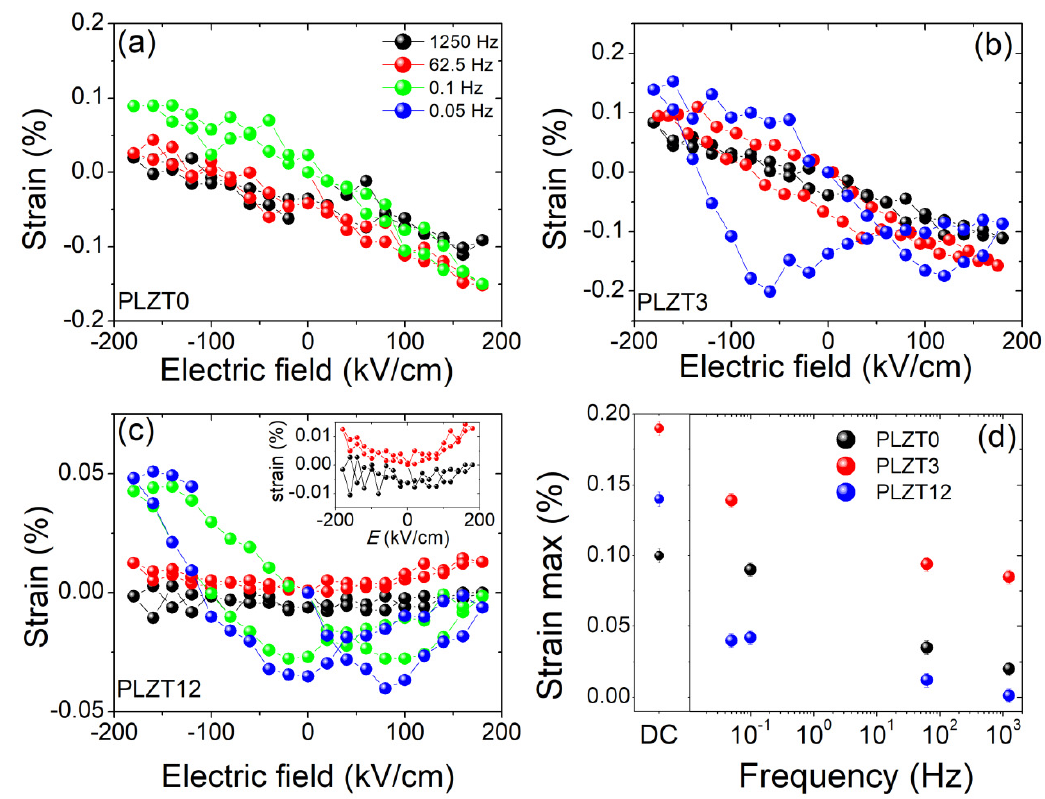
Figure 6. Piezoelectrically-induced strain as a function of electric field for different AC frequencies for ( a ) the PLZT0, ( b ) the PLZT3 and ( c ) the PLZT12 thin films. ( d ) Maximum piezoelectrically-induced strain at E = − 180 kV/cm as a function of the applied AC frequency.